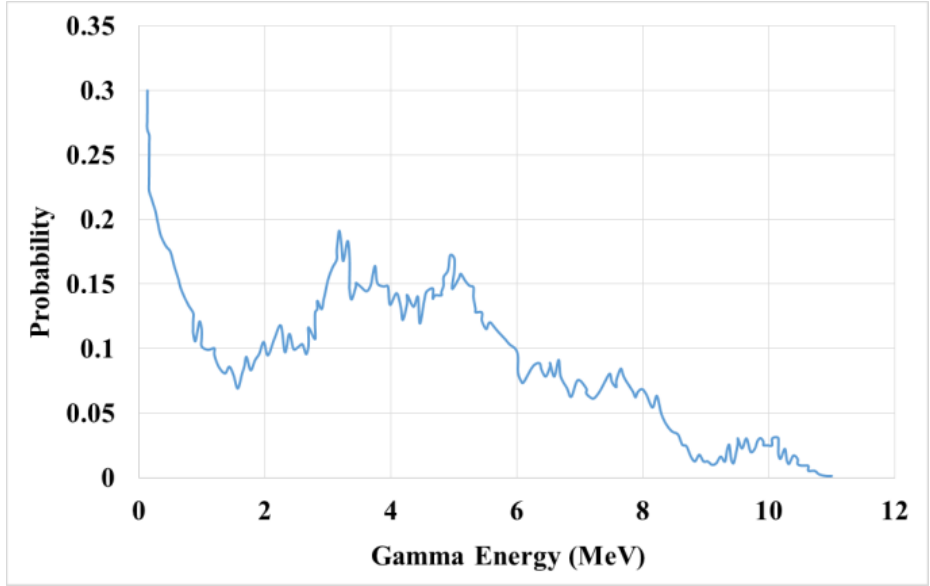
Figure 3. Am–Be neutron source energy spectrum [4].